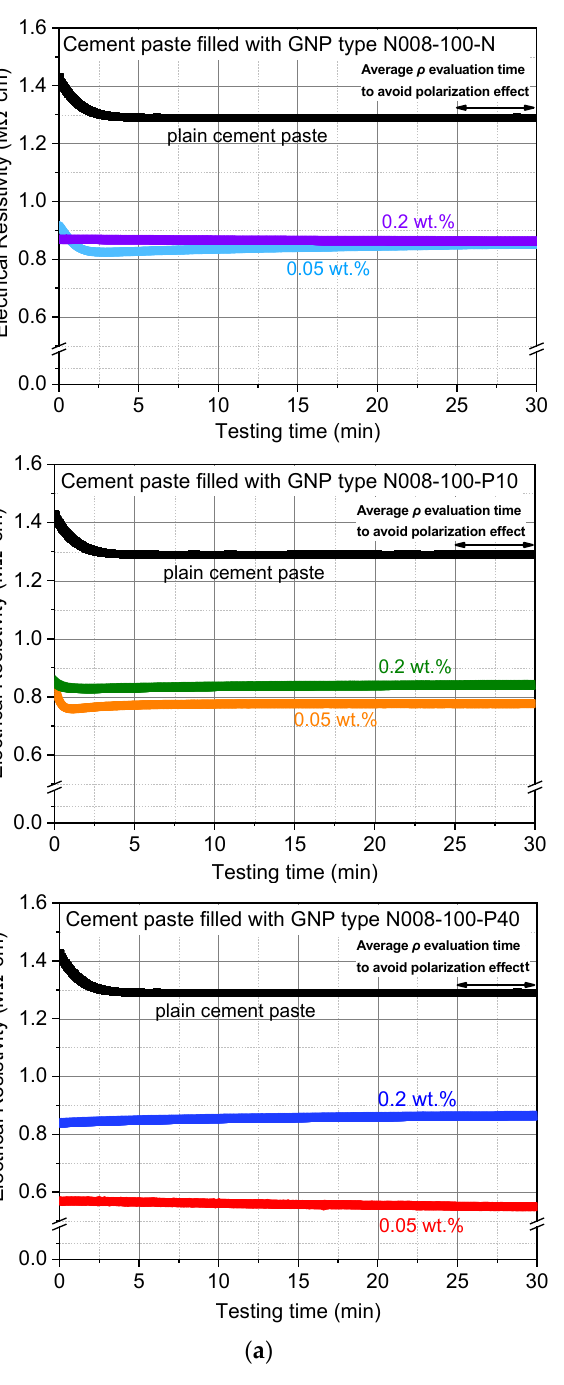
Figure 11. ( a ) Typical electrical resistivity over testing time curves of the GNPs–cement composites; ( b ) Average electrical resistivity results of the GNPs–cement composites.